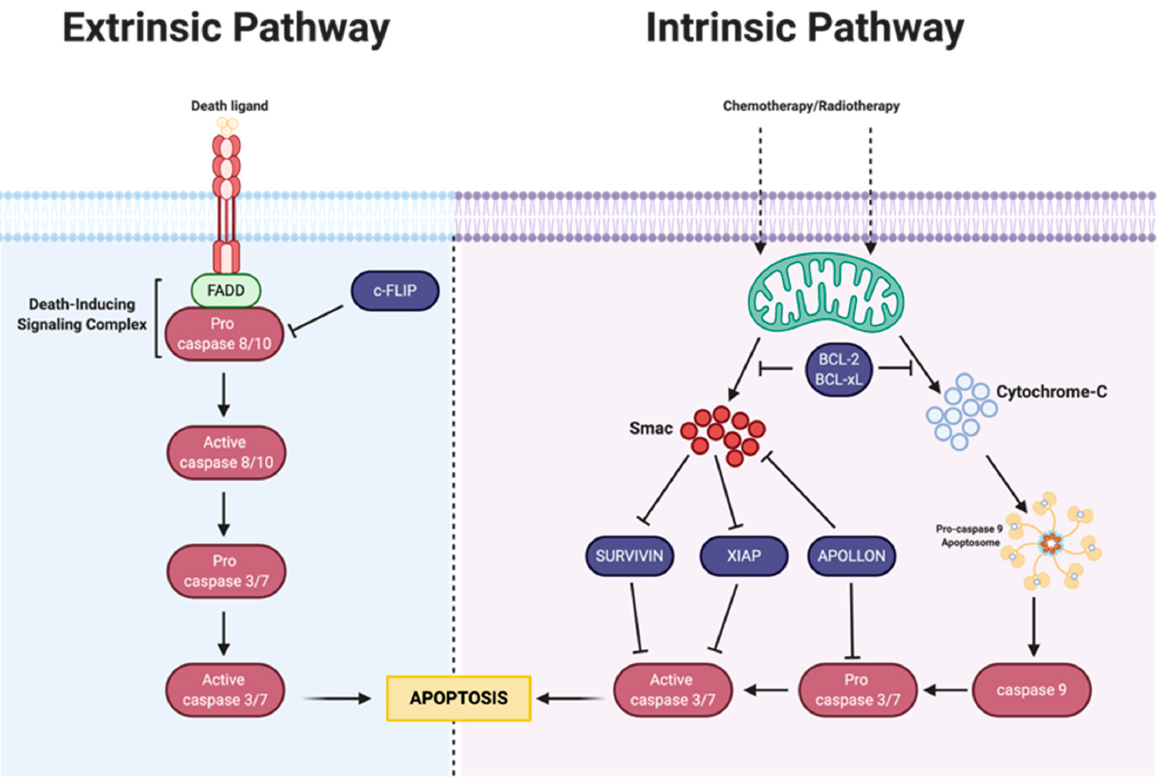
Figure 2. The intrinsic and extrinsic apoptosis pathways. The extrinsic apoptosis pathway is initi- ated through ligand–receptor interactions. The intrinsic pathway is mediated by the release of Smac and cytochrome C from mitochondria (green). Inhibitory proteins (dark purple) can interrupt the caspase cascade (pink), ultimately preventing apoptosis.